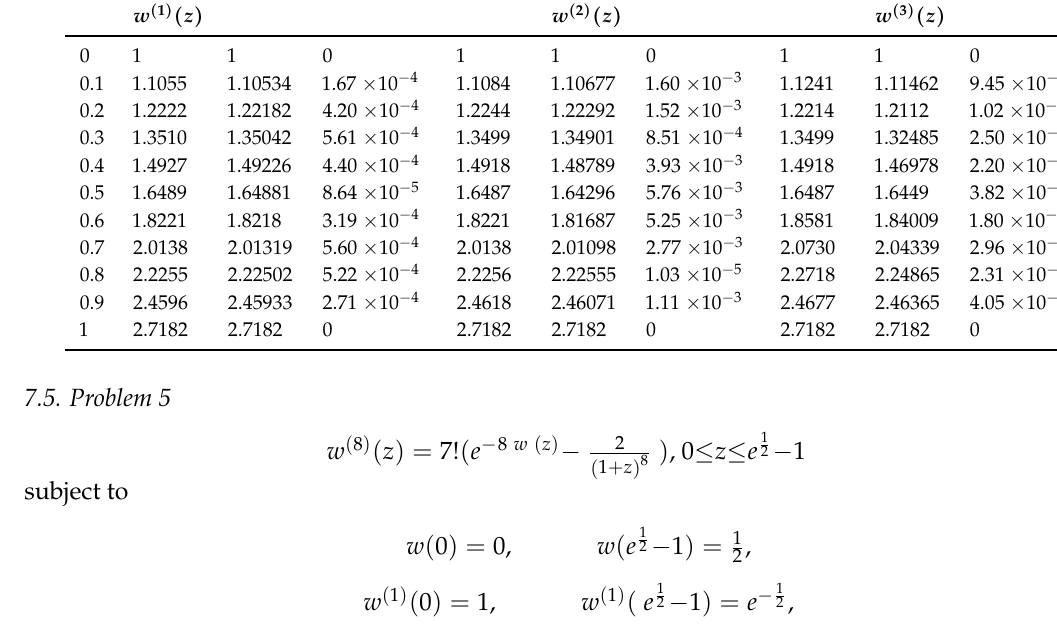
Table 13. Absolute errors at all derivatives at h = 1 Problem